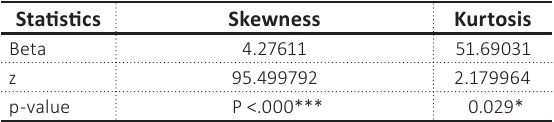
Table 4. Measurement model